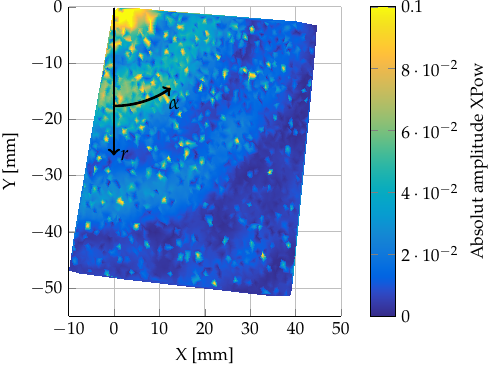
Figure 9. XPOW absolute amplitude distribution at 264